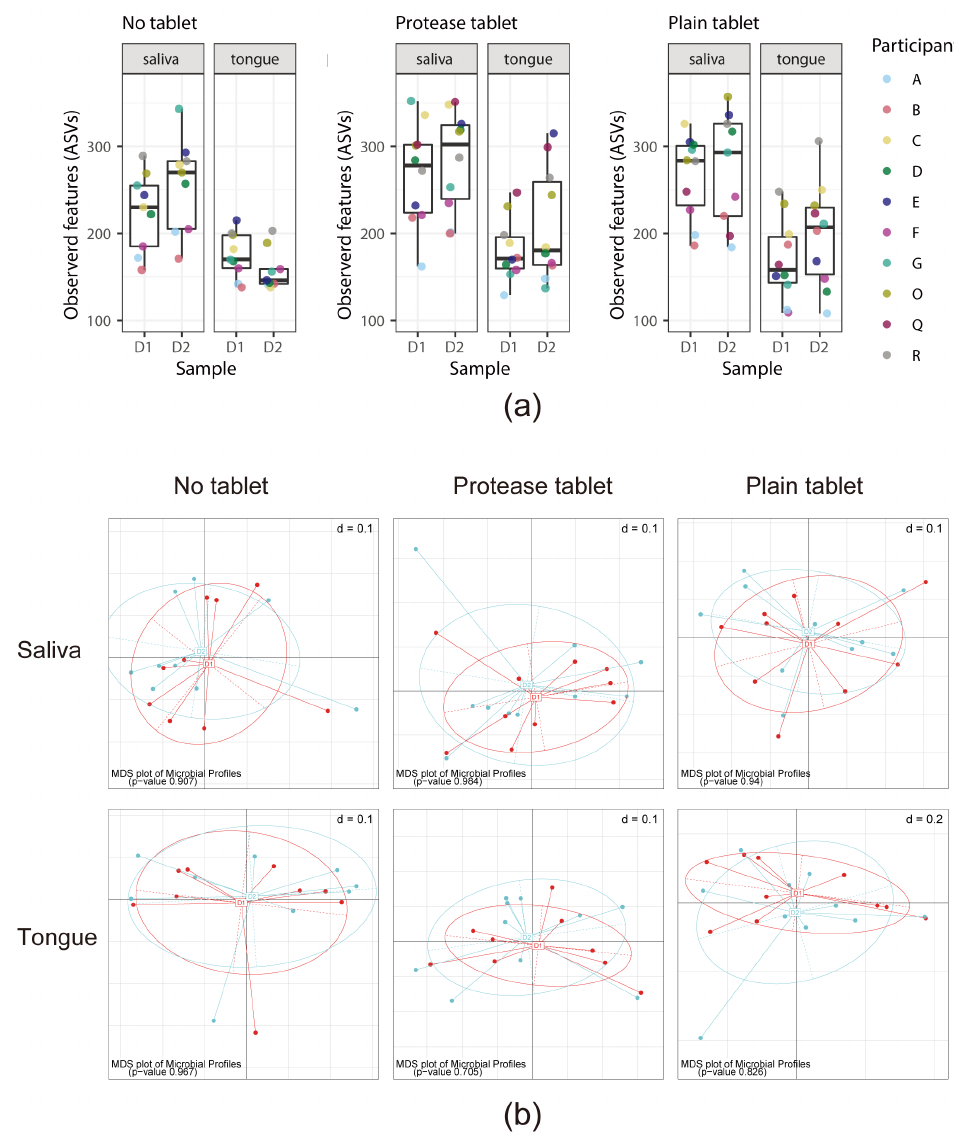
Figure 6. Effect of tablets on alpha and beta diversities of the salivary and tongue microbiomes. ( a ) Box plots of the number of observed amplicon sequence variants (ASV) in the saliva and tongue D1 and D2 samples in the no tablet (left), protease tablet (middle), and plain tablet (right) treatments. Each point indicates a sample. ( b ) multidimensional screening (MDS) analysis of beta diversity in D1 and D2 samples in the saliva (top panels) and tongue (bottom panels) in no tablet (left), protease tablet (middle), and plain tablet (right)